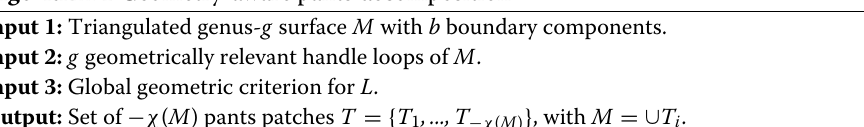
Algorithm 1 Geometry-aware pants decomposition